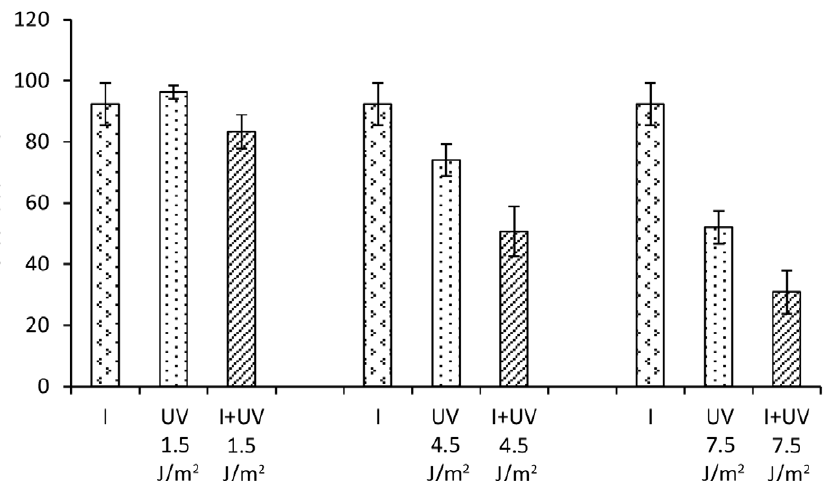
Figure 6. Effect of candesartan cilexetil on UV-induced cytotoxicity using crystal violet assay. XP30RO cells were treated with 24 m M of candesartan cilexetil alone, UV alone at 1.5 J/m 2 , 4.5 J/m 2 , or 7.5 J/m 2 , or in combination. Percent survival was calculated by normalizing the data using the cell survival of untreated cells. The data were obtained from three independent experiments. Error bars represent standard deviations. I: candesartan cilexetil.